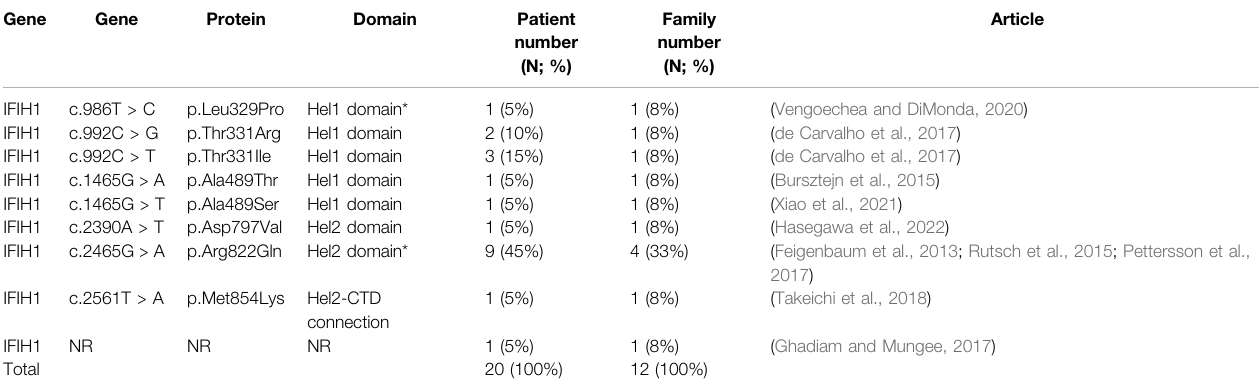
TABLE 1 | Mutation description.